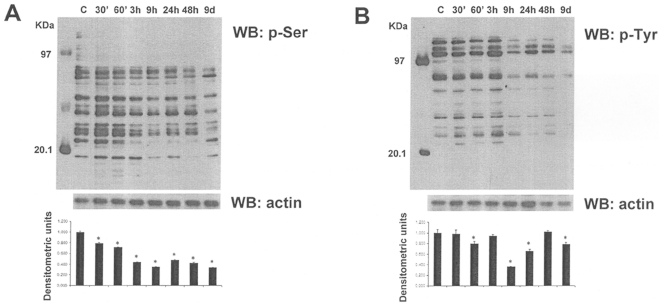
1-DE western blot analysis of NB cells treated or not with ATRA.Representative western blot (of three independent experiments) with anti-phosphoserine (A) and anti-phosphotyrosine (B) antibodies. SJ-N-KP cells were treated with ATRA 10 µM for 30, 60 minutes, 3, 9, 24, 48 hours and 9 days. Control cells (c) were not treated. 15 µg of proteins were analysed on 10% SDS-polyacrylamide gel. Western blot analysis with anti-actin antibodies was performed on the same membranes and used for data normalization. Data (means ± SD) expressed as densitometric units are shown in the lower corner of panels A and B. Significance of the differences between controls and ATRA treated cells: p≤0.05.